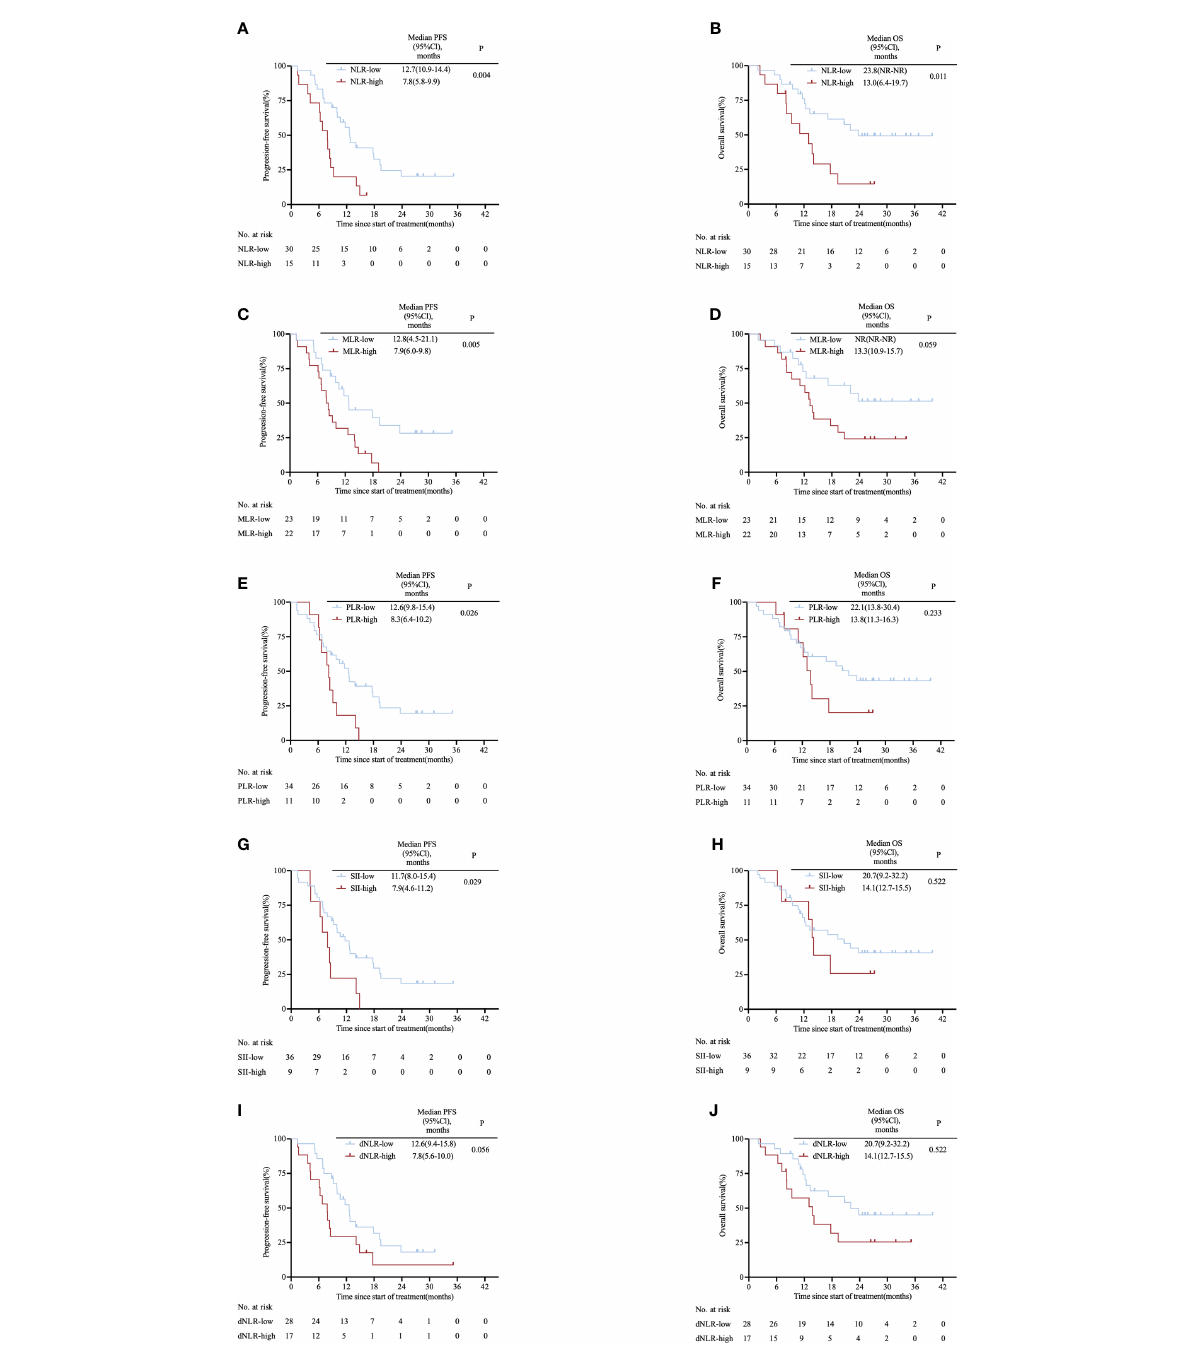
FIGURE 1 Kaplan – Meier survival curves in the clinical trial cohort strati fi ed by in fl ammatory markers for (A) PFS for NLR cut-off, (B) OS for NLR cut-off, (C) PFS for MLR cut-off, (D) OS for MLR cut-off, (E) PFS for PLR cut-off, (F) OS for PLR cut-off, (G) PFS for SII cut-off, (H) OS for SII cut-off, (I) PFS for dNLR cut-off and (J) OS for dNLR cut-off. The p values were calculated using the log-rank test (two-sided). CI , con fi dence interval ; dNLR , derived neutrophil-to-lymphocyte ratio ; MLR , monocyte-to-lymphocyte ratio ; NLR , neutrophil-to-lymphocyte ratio ; OS , overall survival ; PLR , platelet-to-lymphocyte ratio ; PFS , progression-free survival ; SII , systemic immune-in fl ammation